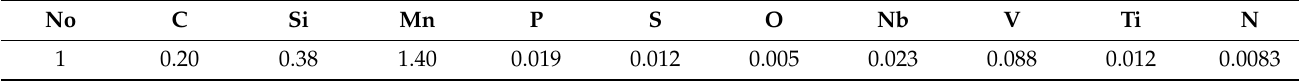
Table 1. Chemical composition of experimental steel (wt%).